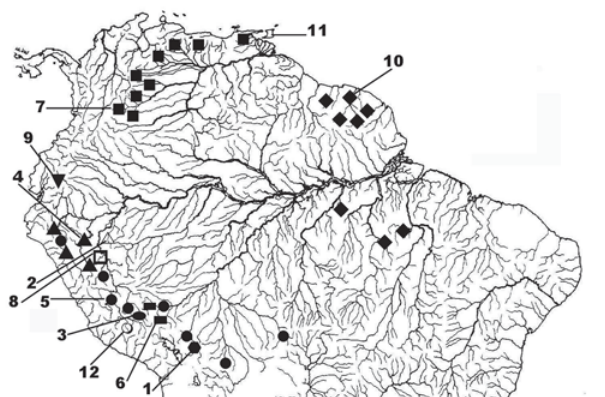
Fig. 4. Map of central and northern South America showing geographic distribution of Hemibrycon beni (1, solid hexagon), H. divisorensis (2, open triangle), H. helleri (3, ellipse), H. huambonicus (4, solid triangles), H. jelskii (5, solid dots), H. inambari (6, rectangles), H. metae (7, solid squares), H. mikrostiktos (8, open square), H. polyodon (9, inverted triangle), H. surinamensis (10, solid diamonds), H. taeniurus (11, Trinidad Island), H. tridens (12, open circle). Some symbols represent more than one lot or locality of specimens. 1-12 = type locality of each